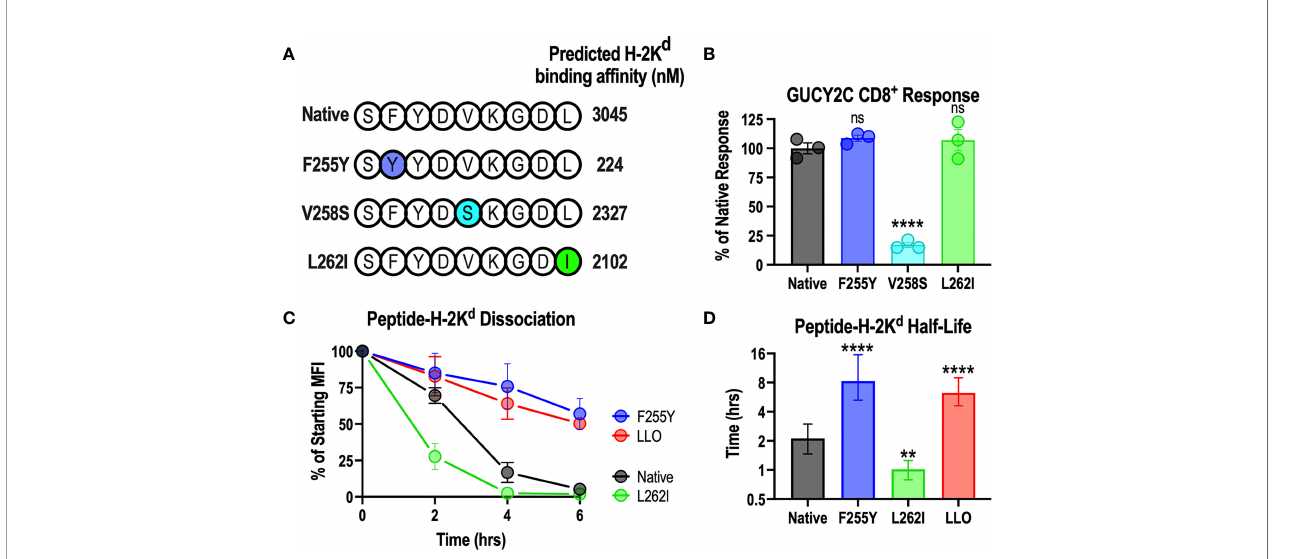
FIGURE 4 | Anchoring residue modi fi cation improves the stability of the GUCY2C 254-262 -H-2K d complex. (A) Shows the amino acid sequence of native and altered peptides predicted with NetMHCPan 4.0 to improve H-2K d binding af fi nity. (B) Splenocytes from mice immunized against the native GUCY2C 254-262 epitope with Ad5- GUCY2C were incubated overnight with native GUCY2C 254-262 peptide or altered GUCY2C peptides, and the number of IFN g -producing T cells were quanti fi ed by ELISpot (relative to recognition of the native GUCY2C 254-262 peptide). Normalized spot counts were compared by one-way ANOVA to native GUCY2C 254-262 peptide with Bonferroni correction for multiple comparisons. Error bars indicate mean +/- SEM of technical replicates. (C) The stability of the peptide-H-2K d complexes was assessed using RMA-S H-K d cells, and the normalized speci fi c MFIs are shown. Error bars indicate mean +/- SEM of two experiments. (D) Half-lives (t 1/2 ) were determined by nonlinear regression of (C) . Error bars indicate computed t 1/2 +/- 95% con fi dence intervals. Statistical comparisons were made to native GUCY2C by extra sum-of-squares F Test with Bonferroni correction. **P < 0.01; ****P < 0.0001; ns, not signi fi